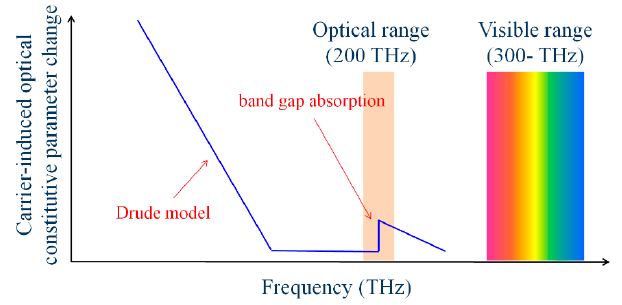
Figure 6. Rate of variation in optical properties, outlined as a function of light frequency.